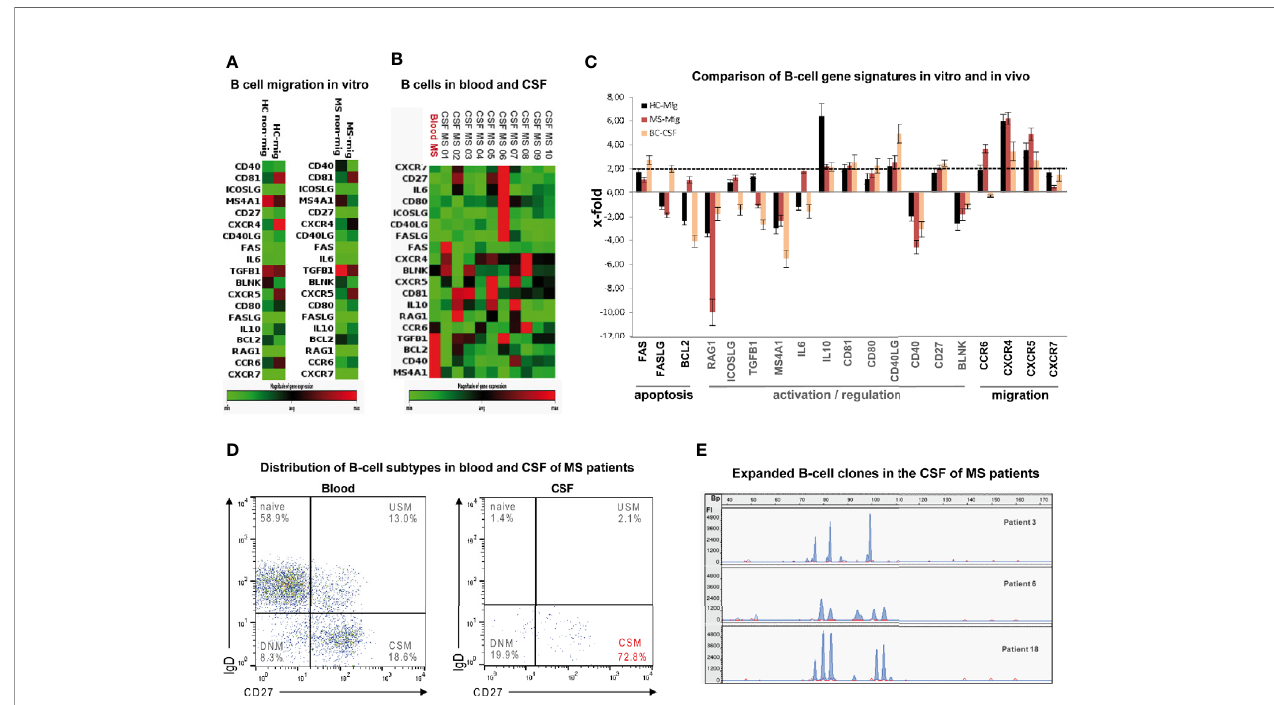
FIGURE 5 | Phenotypes and gene signatures of B cells migrated in vitro compared to intrathecal B cells from MS patients. Heat map of customized PCR array showing differential expression of 19 genes involved in apoptosis, activation/regulation and migration in (A) in vitro migrated against a mix of CXCL12 and -13 (mig = average expression of 15 samples) and non-migrated (non-mig = average expression of 15 samples) blood-derived B cells obtained from 15 healthy donors and ten MS patients and in (B) CSF-derived (patient 01 – 10) and blood-derived ( “ Blood MS ” = average expression of 10 samples). B cells obtained from 10 MS patients with active disease as determined by PCR array. Green = low expression; red = high expression. (C) Comparison of B-cell gene signatures in vitro and in vivo : Bars denote means of x-fold changes in gene expression in B cells obtained from 15 HC (mig-HC, black) and from ten MS patients (mig-MS, red) that had migrated through the HIBCPP layer as well as in CSF-derived B cells obtained from 10 MS patients with active disease (CSF-MS, yellow). Error bars denote SD. (D) Flow cytometry of CSF-derived total CD19 + B cells obtained from 10 MS-patients with active disease shows predominance of class-switched memory cells (CSM) (USM: non-switched memory, DNM: double negative memory). (E) Electrophoretic gene scanning pro fi les of fl uorescent IgH CD3 PCR amplicons generated from CSF- derived total CD19 + B cells obtained from three MS-patients with active disease (patients 3, 6, and 18) depict 4-6 expanded B-cell clones. Relative fl uorescence intensities (FI, y-axis) are plotted against amplicon size in base pairs (Bp,